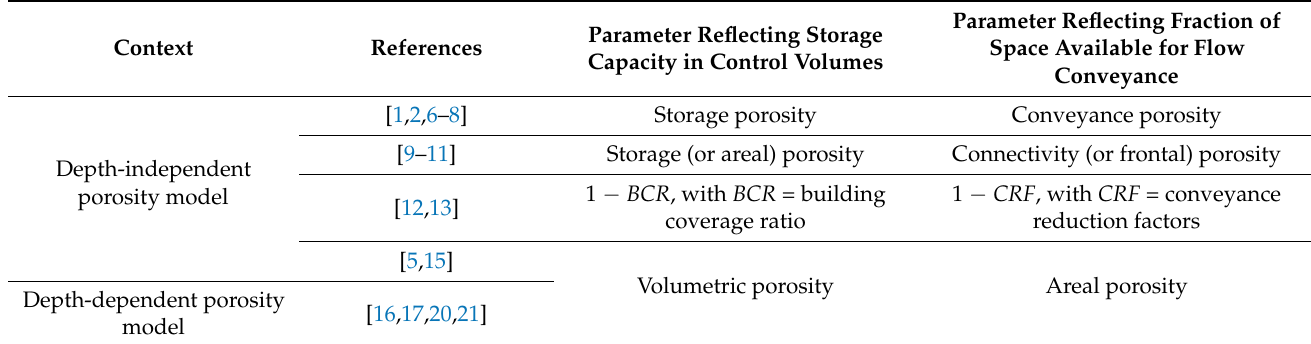
Figure 3. Sketch of a control volume and ( a ) the part V f occupied by water, ( b ) the fluid–fluid exchange boundary ∂ V f , ( c ) a horizontal surface at a given level z and its part occupied by water Ω f , as well as ( d ) the fluid–fluid exchange border ∂ Ω f of the horizontal surface. Table 2. Nomenclature used in existing research to denote storage and conveyance